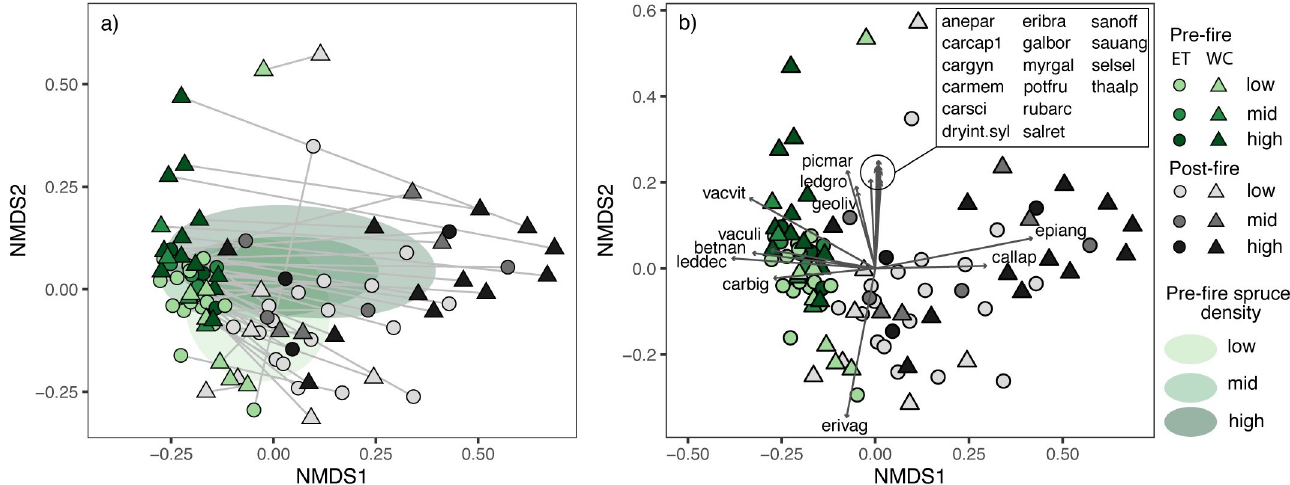
Fig 6. Two-dimensional NMDS representation of pre- and post-fire plant community composition (Bray–Curtis distance) at each site (stress = 0.15, 48 sites, 80 species). Points indicate a site at a given sampling time. Point colors indicate pre- (grey) and post-fire (green) plant communities and color shades indicate pre-fire spruce density. On panel a), the standard deviation ellipse is shown for each spruce density group, with the color shadings corresponding to pre- fire spruce density. Light grey lines link the same site before and after fire. On panel b), the dark grey arrows are overlays of species vectors significantly associated with plot position in the ordination space ( p � 0.001). Arrow lengths were halved to facilitate visualization. Species codes can be found in S2